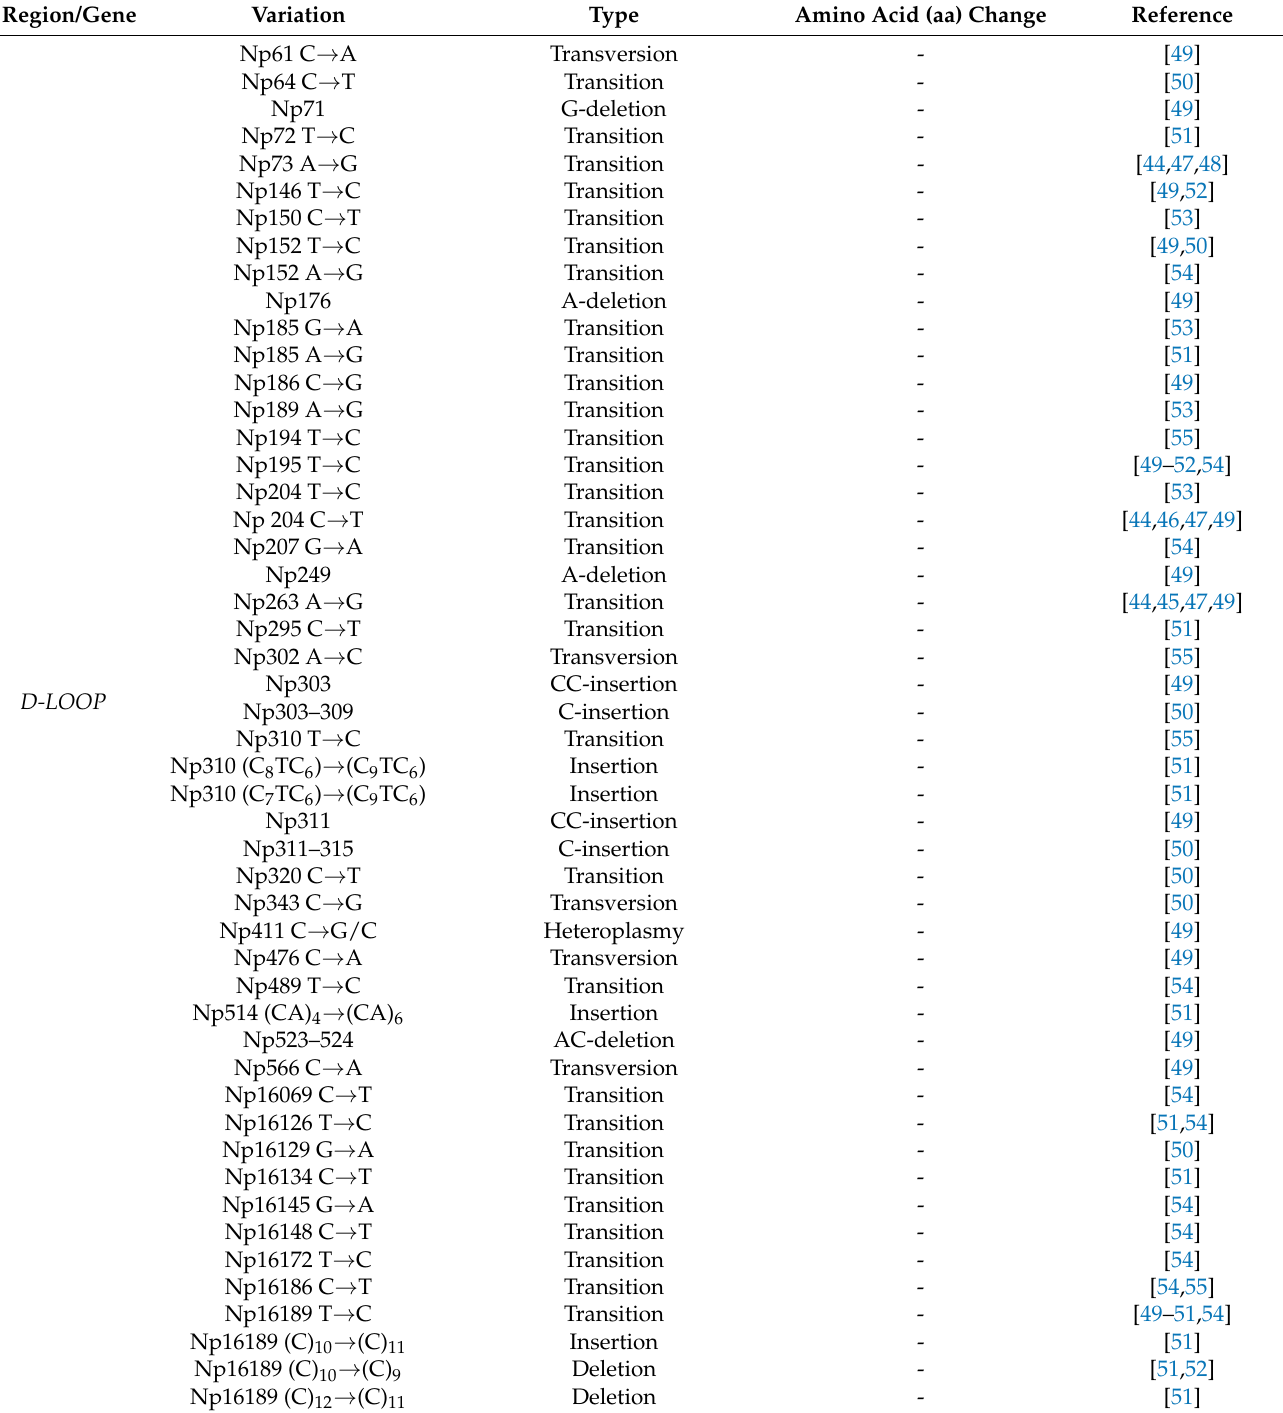
Table 1. Mitochondrial DNA alterations in